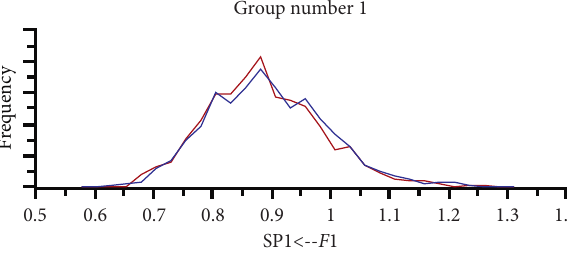
Figure 13: First and last combines polygon SP1. Table 6: ML and Bayesian